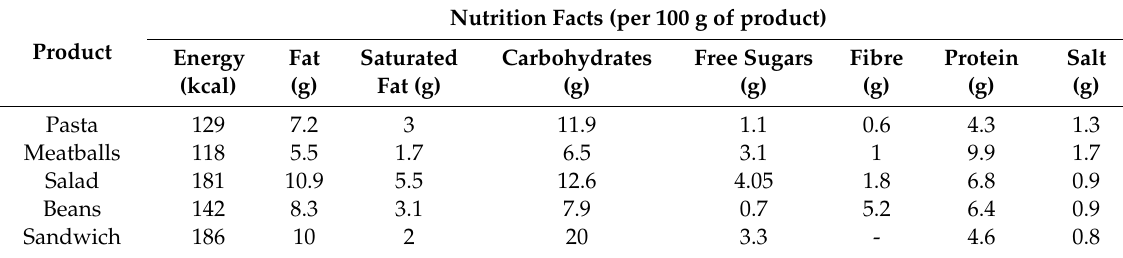
Table A1. Nutritional facts of the ready-to-eat